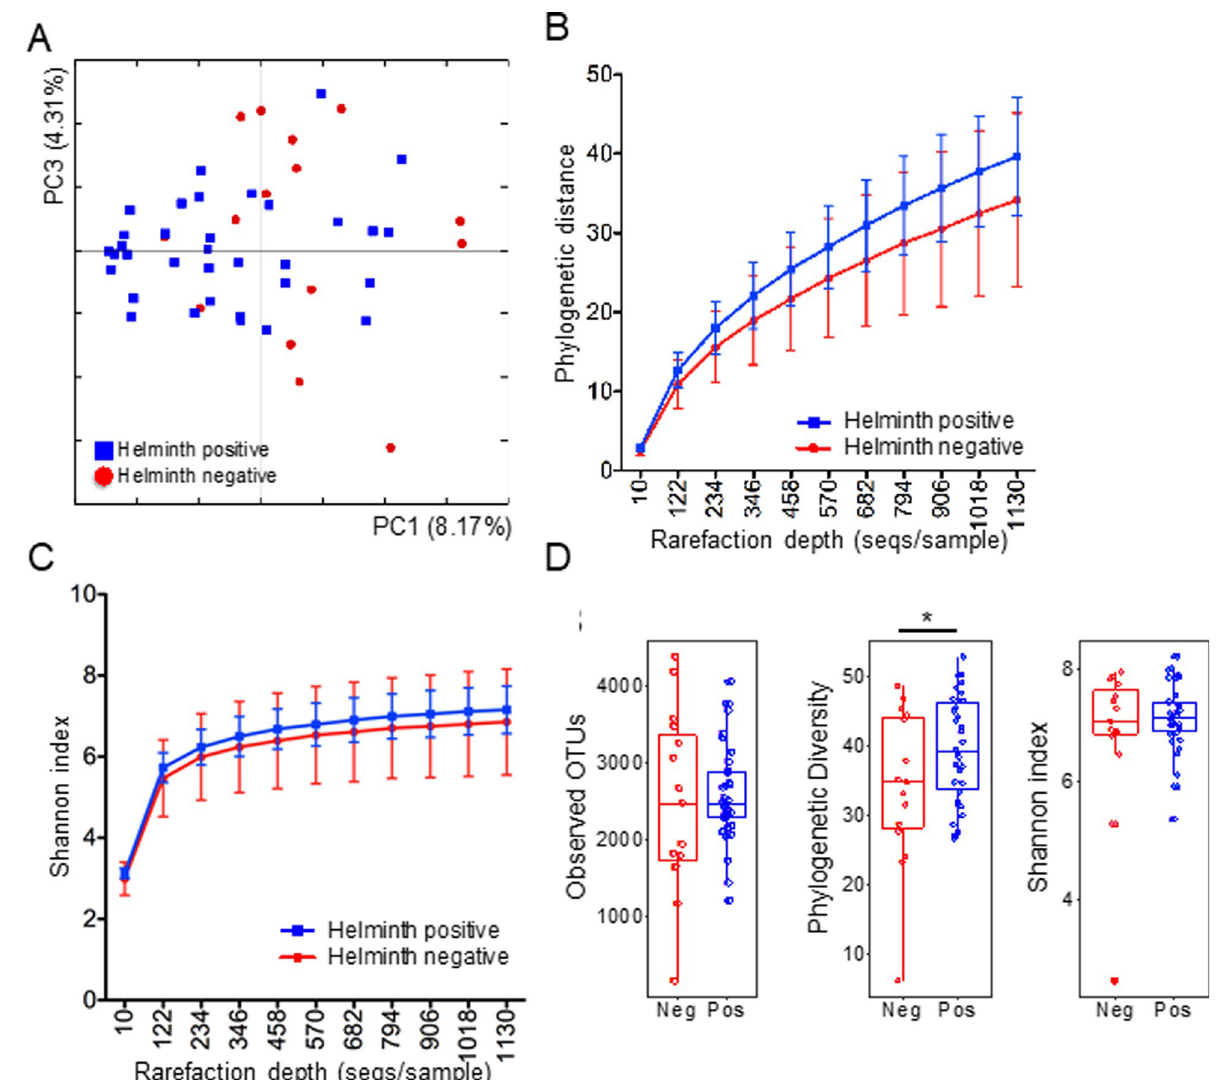
Fig 2. Beta and alpha diversity for the 51 subjects. ( Panel A ) PCoA of the microbial communities in helminth-positive and helminth-negative samples. Clustering of helminth-positive subjects could be observed, which is statistically significant (p = 0.04). Rarefaction curves calculated for phylogenetic distance ( Panel B ) and Shannon index ( Panel C ) demonstrating the higher microbial diversity found among helminth positive subjects. ( Panel D ) Alpha diversity metrics (observed OTUs, Phylogenetic Diversity and Shannon Index) were compared between helminth positive (n = 34) and negative (n = 15) individuals. Analysis methods are detailed in the original publication. Two individual samples with < 1000 sequencing reads were removed from the alpha diversity analysis. � p < 0.05 by non-parametric two-sample t-test as implemented in QIIME compare_alpha_diversity.